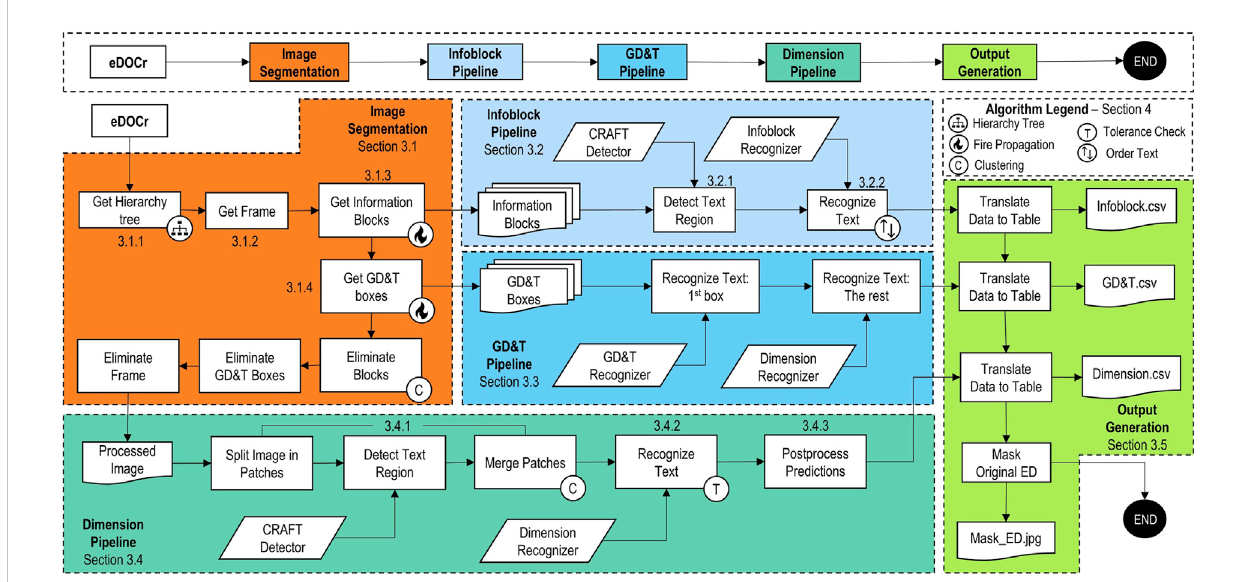
FIGURE 2 eDOCr detailed Flowchart. On top, the summarized work fl ow followed in Section 3. Below, a more complete representation of the whole system. The number next to the boxes refer to the subsection where they are explained in detail. The algorithms used are explained in Section